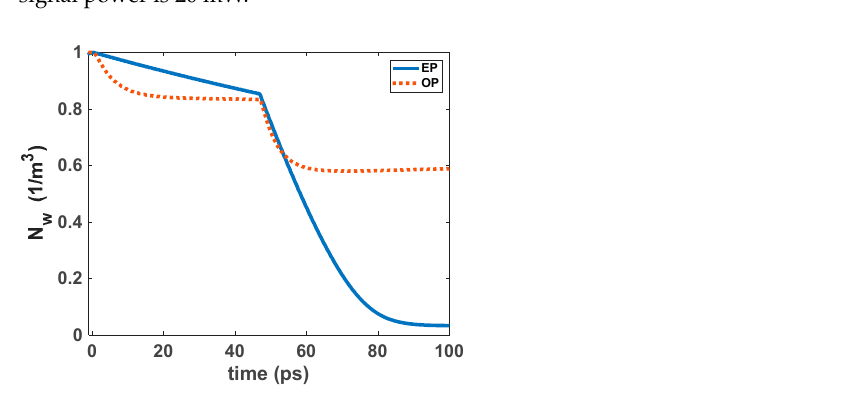
Figure 10. Normalized WL dynamics for both EP and OP methods. The plots are normalized to their maximum value.